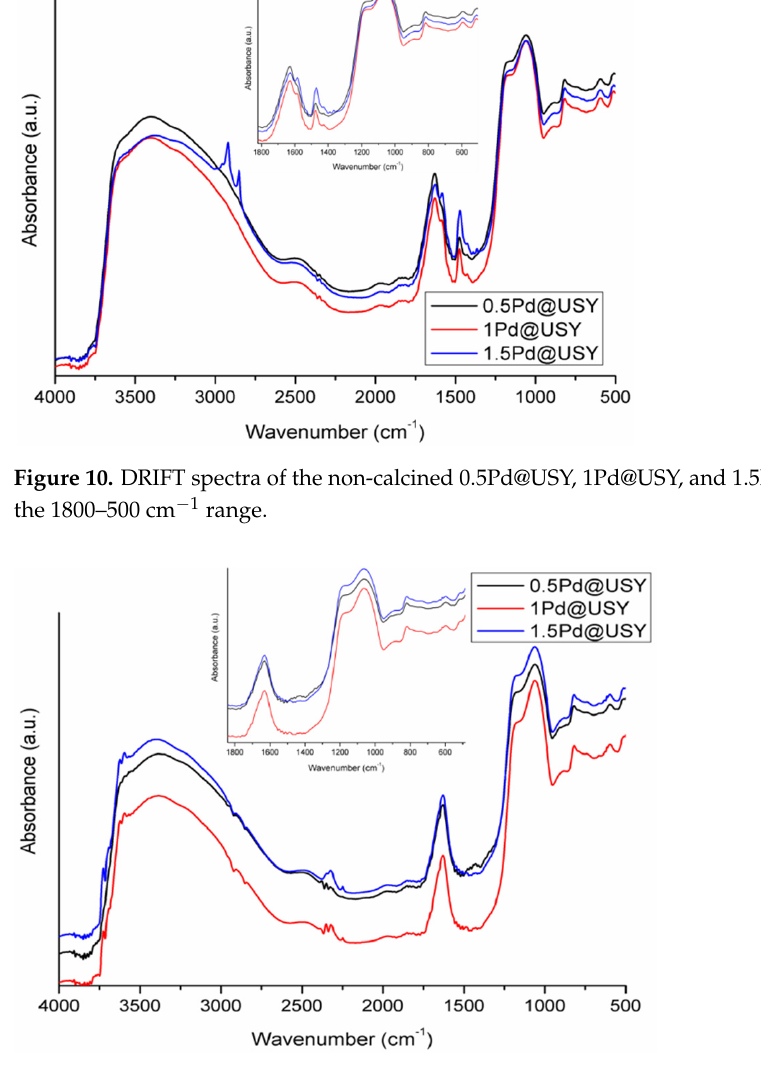
Figure 9. DRIFT spectra of the 0.5Pd@Y, 1Pd@Y, and 1.5Pd@Y and an inset in the 1500–400 cm − 1 range.